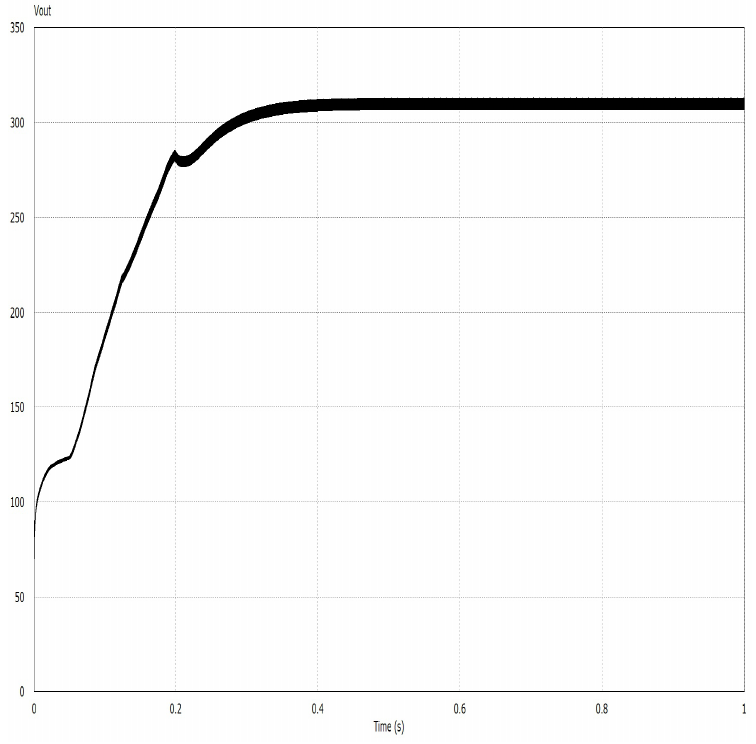
Figure 14. Simulation of output voltage vs.